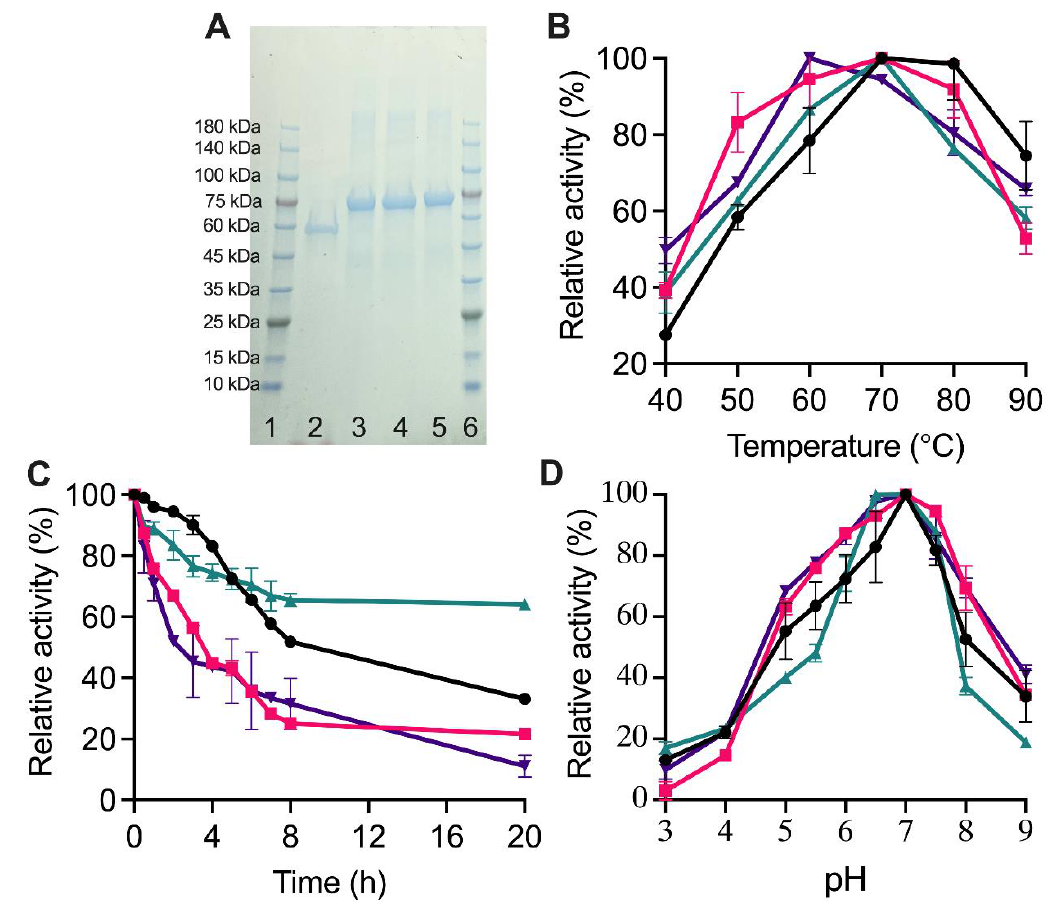
Figure 3. Biochemical characterization of Tu α GT and SBD-Tu α GT fusions. ( A ) SDS-PAGE of purified enzymes. Lanes 1 and 6: Marker, Lane 2: Tu α GT (6.5 µ g), Lane 3: SBD St1 -Tu α GT (6.5 µ g), Lane 4: SBD St2 -Tu α GT (6.5 µ g), Lane 5: SBD GA -Tu α GT (6.5 µ g); ( B ) Temperature dependence for maltotriose disproportionation; ( C ) Thermostability at 50 ◦ C; ( D ) pH dependence for maltotriose disproportionation. Tu α GT (black), SBD St1 -Tu α GT (red), SBD St2 -Tu α GT (green), and SBD Ga -Tu α GT (purple). Activity at pH or temperature optima was defined as 100% for the individual